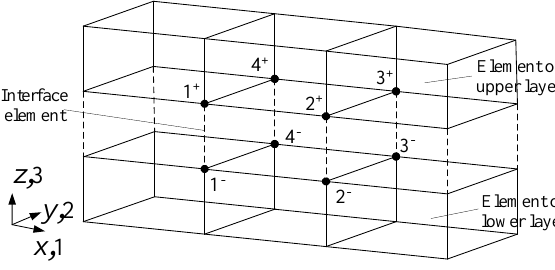
Figure 1. Zero-thickness cohesive interface element.